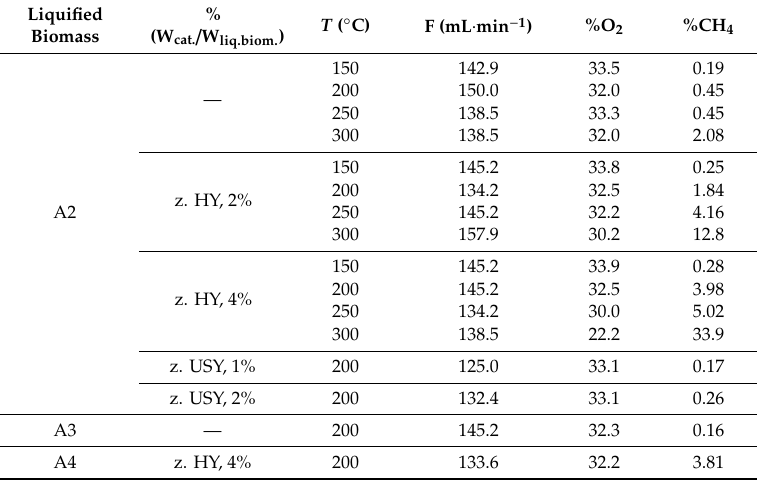
Table 5. Experimental results in the methanation reactor, for di ff erent reaction temperatures and di ff erent weight content catalyst.